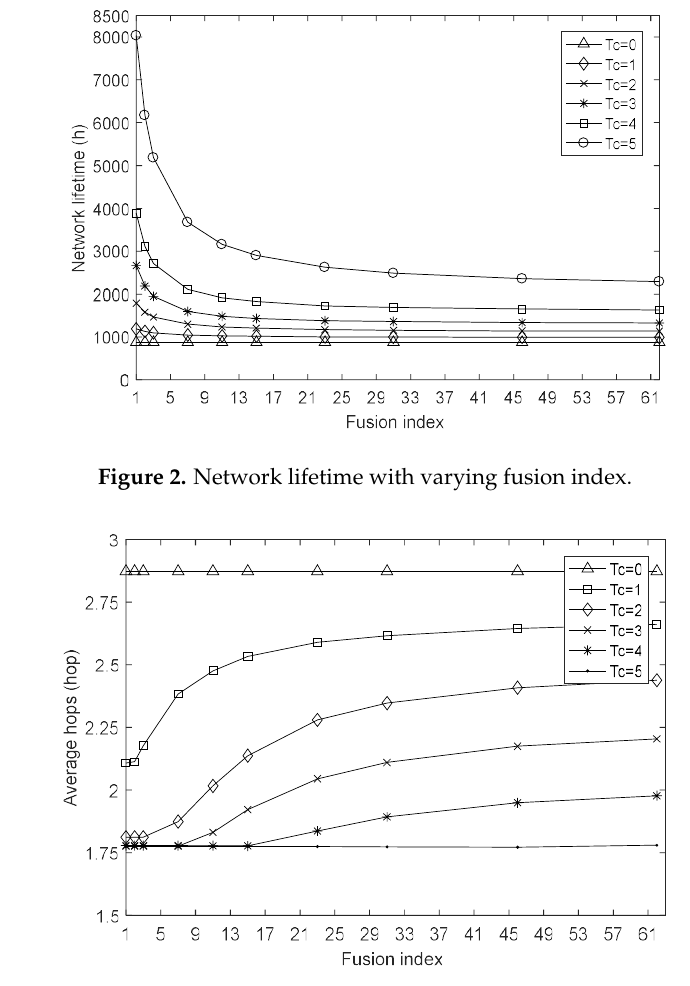
Figure 3. Average hops with varying fusion index.